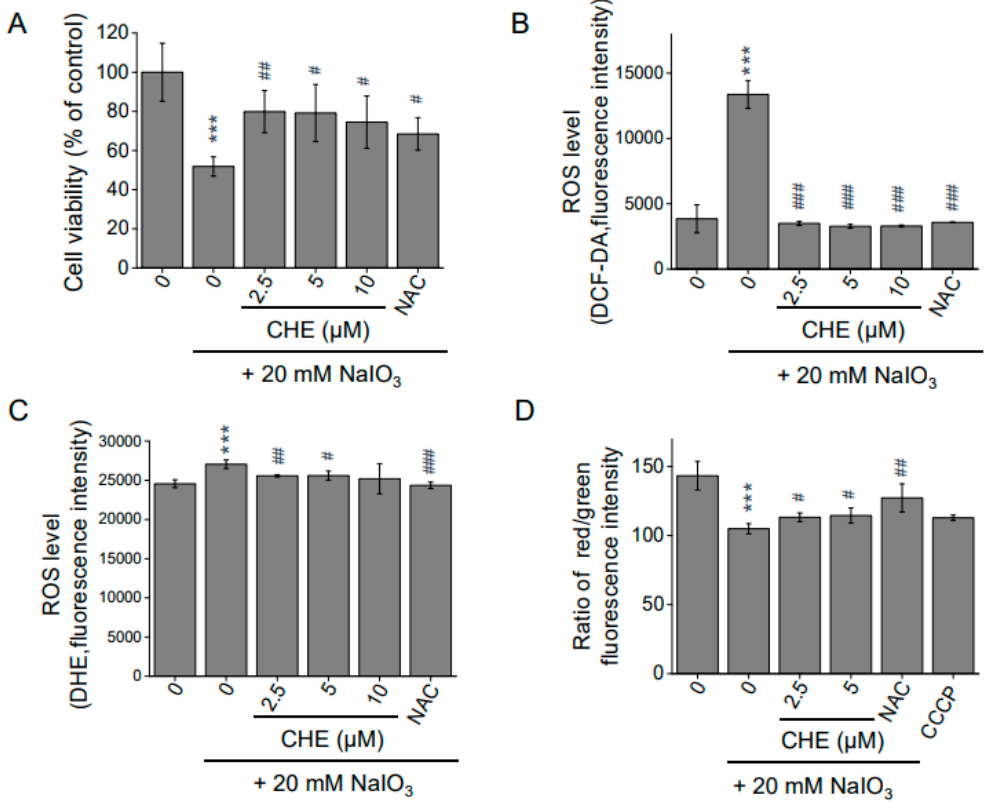
Figure 7. Protective effects of CHE against NaIO 3 -induced cell damage in ARPE-19 cells. ( A ) Cells were pre-treated with CHE at the indicated concentrations or 0.1% DMSO (vehicle control) for 2 h and then incubated with or without 20 mM of NaIO 3 for an additional 24 h. Cell viability was measured via the CCK-8 assay. ROS levels were measured by the DCFDA ( B ) and DHE ( C ) assays. N -acetyl-cysteine (NAC, 4 mM) was used as an antioxidant control. ( D ) CHE attenuated NaIO 3 -induced loss of mitochondrial membrane potential. After pre-treatment with 2.5 or 5 μ M CHE for 2 h, ARPE-19 cells were incubated with or without 20 mM NaIO 3 for an additional 24 h. Red/green fluorescence intensity was quantified via the JC-10 assay (A). Carbonyl cyanide m-chlorophenyl hydrazone (CCCP, 40 μ M) and N -acetyl-cysteine (NAC, 4 mM) were used as positive and antioxidant controls, respectively. *** p < 0.001, versus control group; # p < 0.05, ## p < 0.01, ### p < 0.001 versus the NaIO 3 -treated group.